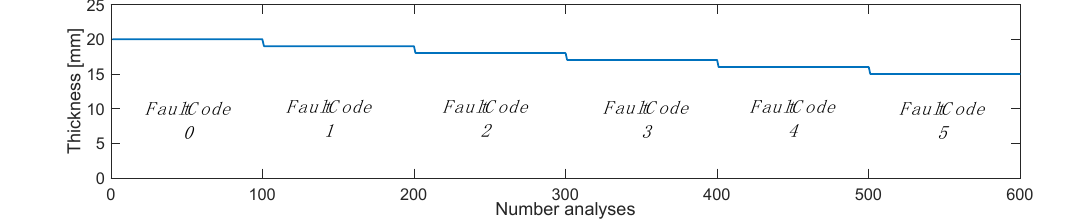
Figure 5. Outline of analysis performed for AI training.